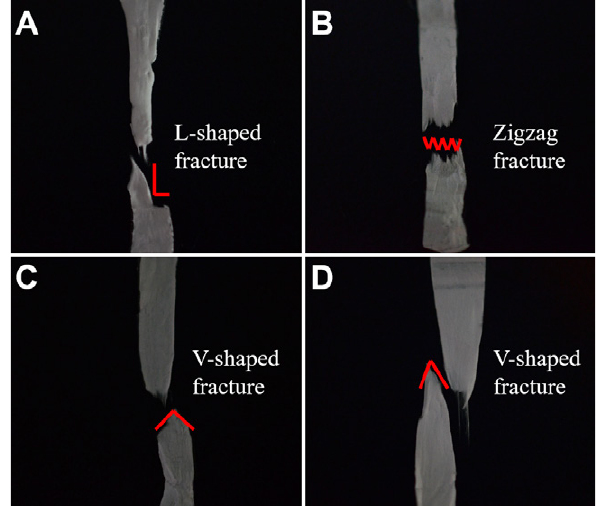
Figure 11: Fracture morphology of PAN nanofiber members with different rotary speeds: A) 1000rpm; B) 1500rpm; C) 2000rpm;